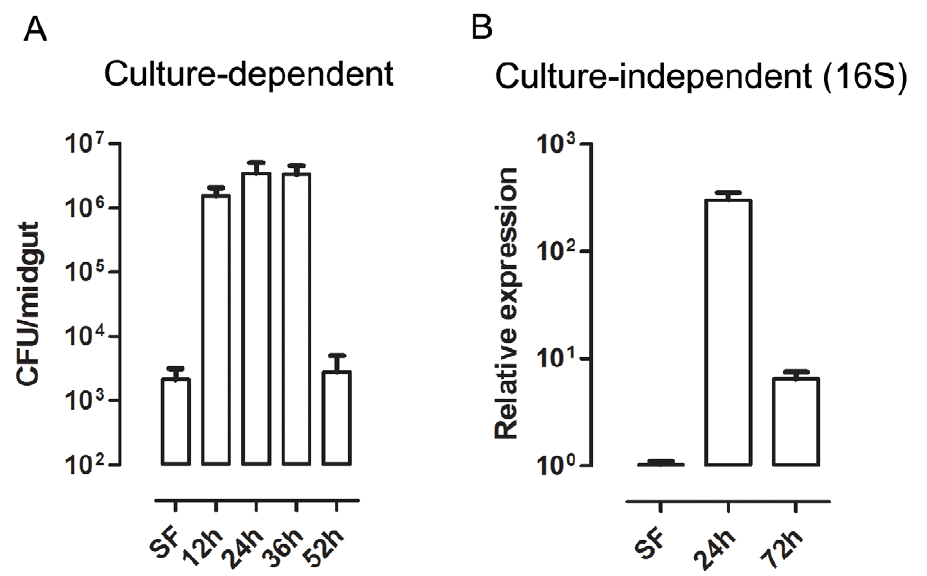
Figure 5. Time-course of microbial growth in Aedesaegypti midgut before and after a blood meal. (A) Evaluation of cultivable bacterial population in sugar-fed (SF) and blood-fed midguts dissected at different times after feeding. (B) Culture-independent evaluation of microbiota in sugar-fed (SF) and blood-fed midguts through qPCR for bacterial ribosomal 16S RNA [54].